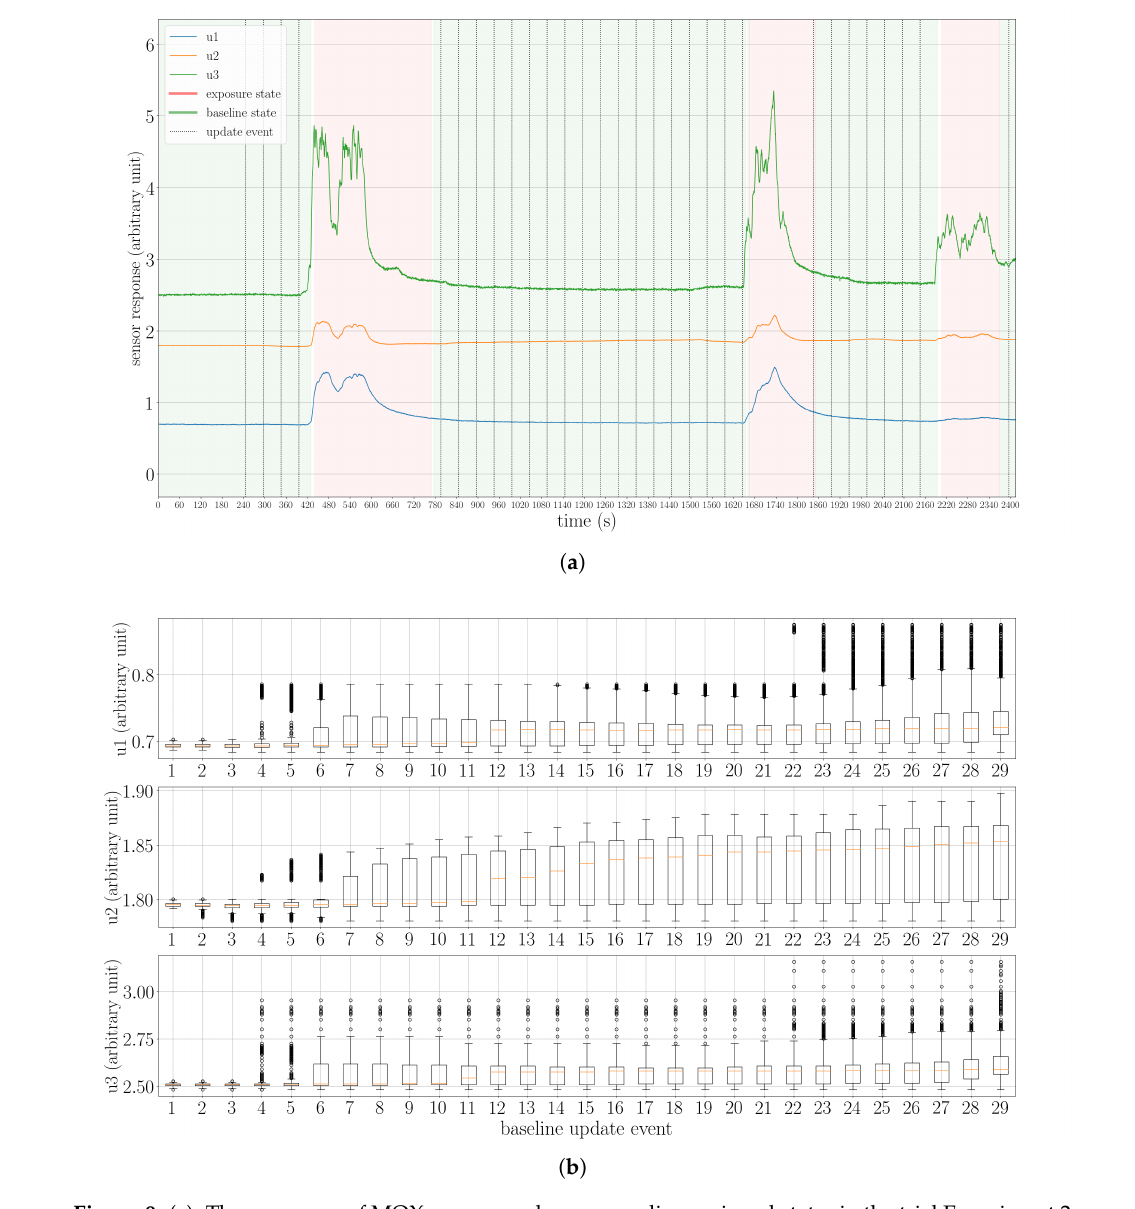
Figure 9. ( a ): The responses of MOX sensors and corresponding assigned states in the trial Experiment 2. In this case, the ground-truth baseline is never fully recovered; ( b ): The baseline offsets learned in each periodic updates ( T UB = 50 s) during the baseline states. The drift effect is observable for all three MOX